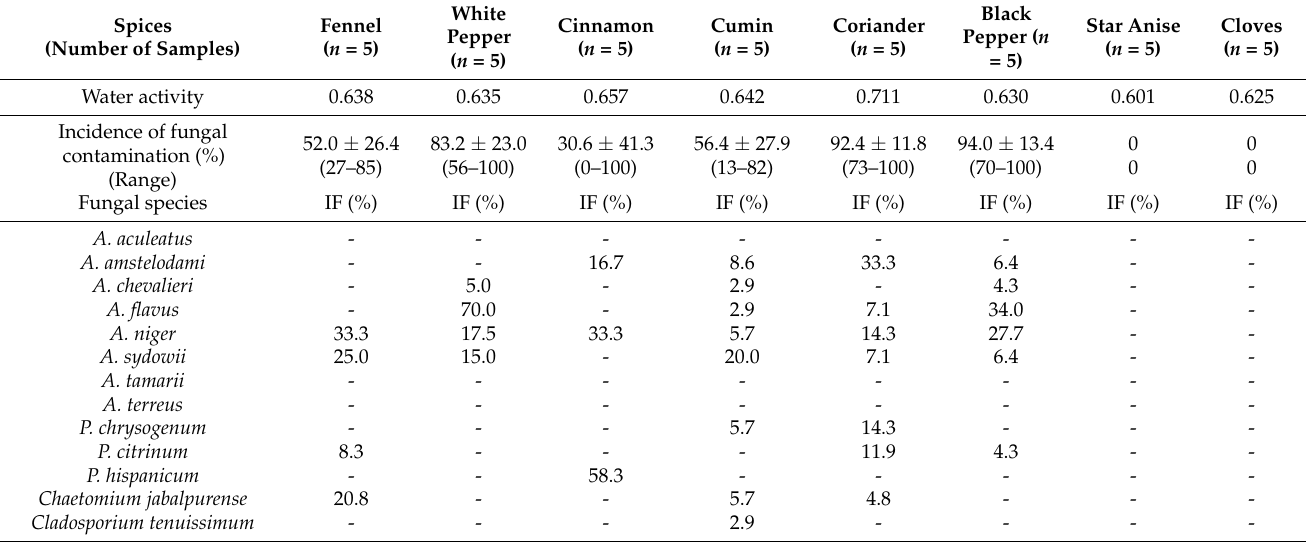
Table 2. Incidence of fungal infection and isolation frequency of fungal species from whole